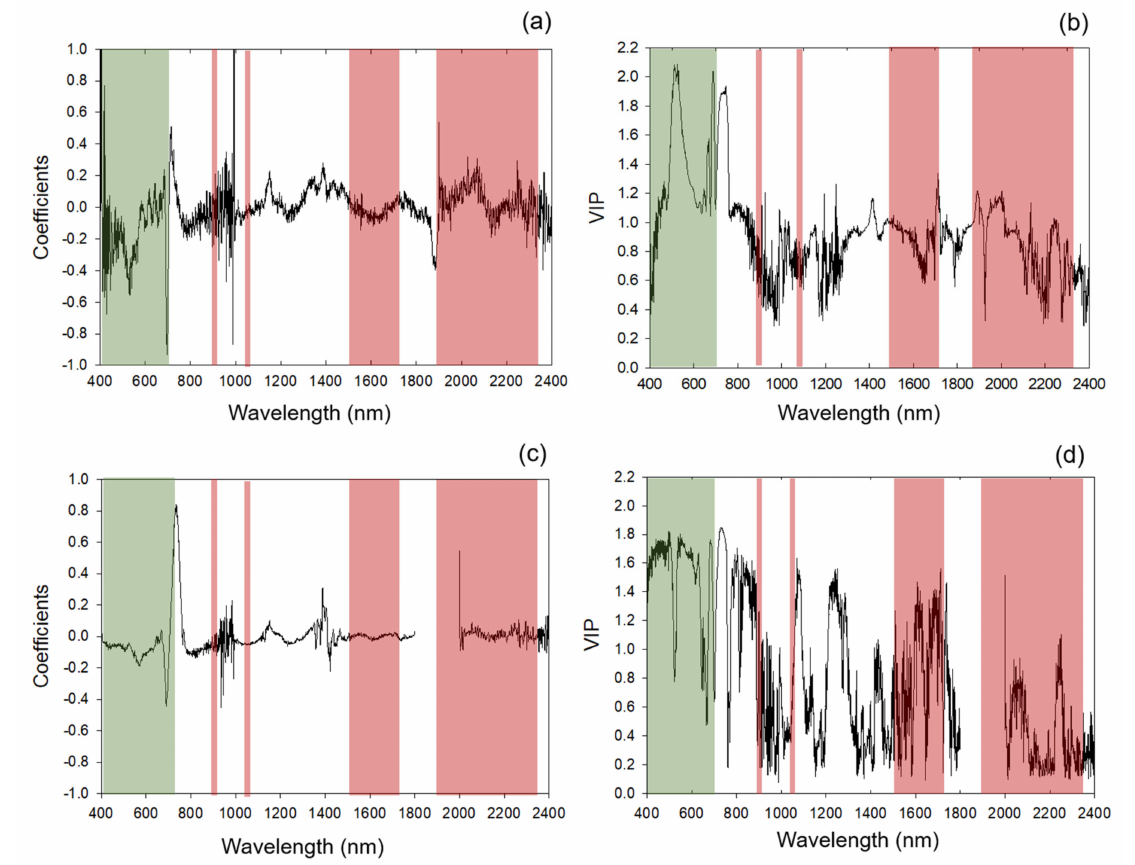
Figure 2. Standardized coefficients and variable importance for the projection (VIP) selection for 2017 models. ( a , c ) Standardized coefficients of 2017 models for leaf-level and canopy-level measurements, respectively; ( b , d ) VIP of 2017 models for leaf-level and canopy-level measurements, respectively. Shaded areas: regions of absorption feature present between 400 and 2400 nm for chlorophyll (green) and protein (red). Specific absorption features within these regions are listed in Appendix C Table